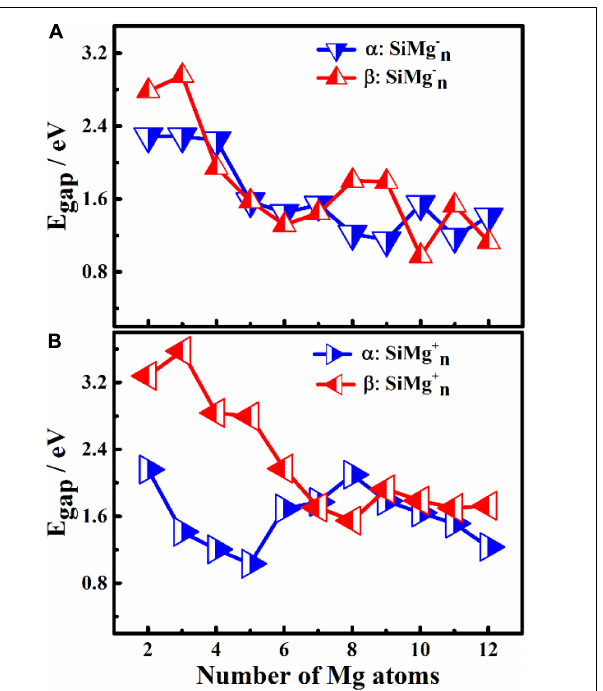
FIGURE 5 | HOMO-LUMO energy gap of α and β electrons in ground state of panels (A) E gap for SiMg − 1 n , (B) E gap for SiMg + 1 n ( n = 2–12) clusters.